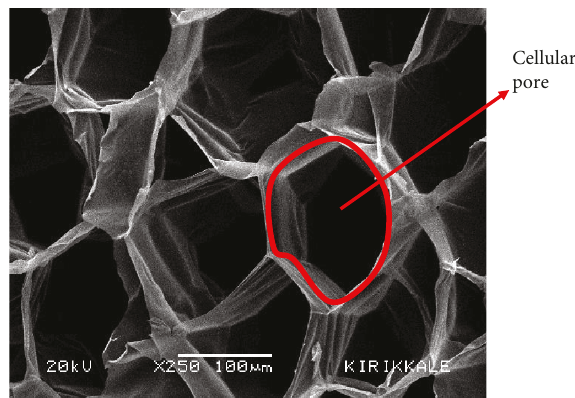
Figure 4: X35 microstructure image for the expanded polystyrene with the density of 25 kg/m 3 .